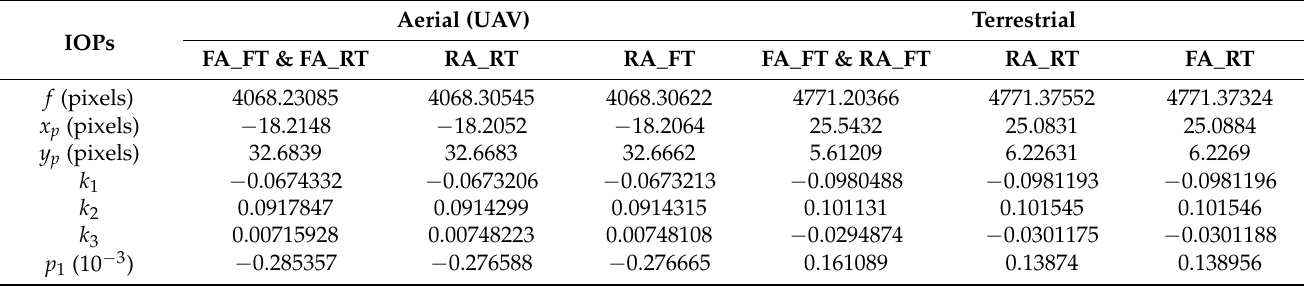
Table 4. IOPs of aerial (UAV) images and terrestrial images after the BA of the Stadthaus dataset using different SC strategies.